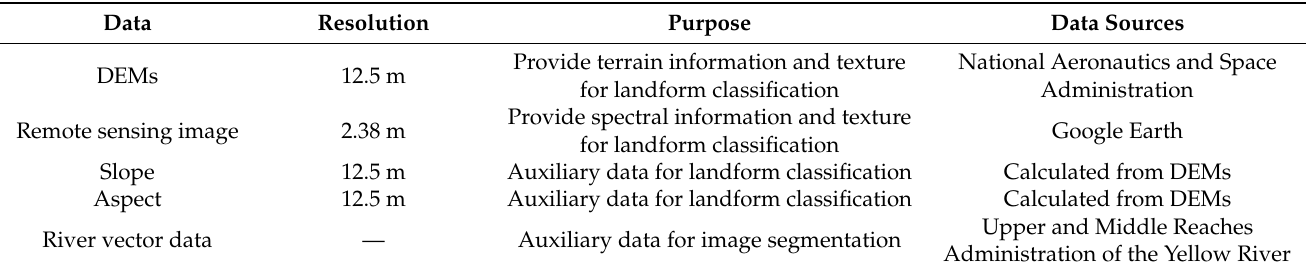
Table 1. The main data used in the study and its